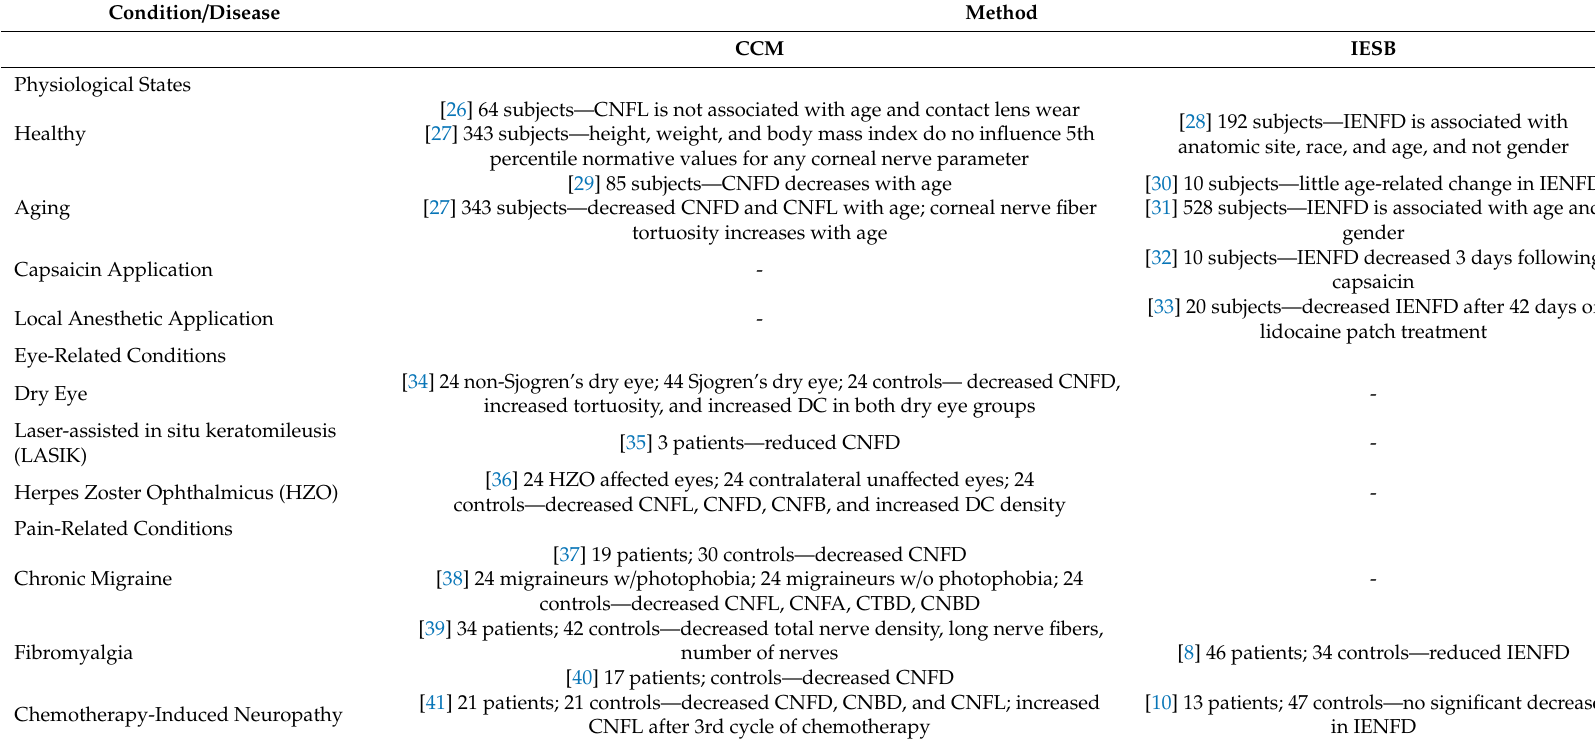
Table 1. Reports of cornea or skin-based nerve metrics on corneal confocal microscopy (CCM) or intraepidermal skin biopsy (IESB) measures in di ff erent conditions / disease states in